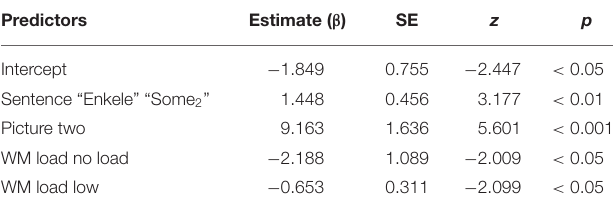
TABLE 2 | Overview of the final model for the responses to the implicature control items, with reference levels: Sentence: “Sommige” “Some 1 ,” Picture: All, WM Load: